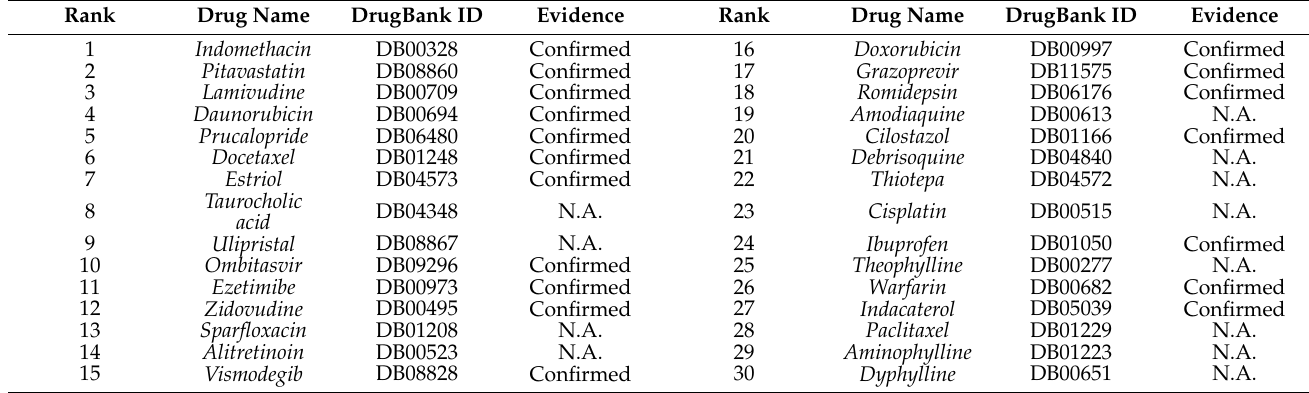
Table 6. The top 30 interactions of Regorafenib .